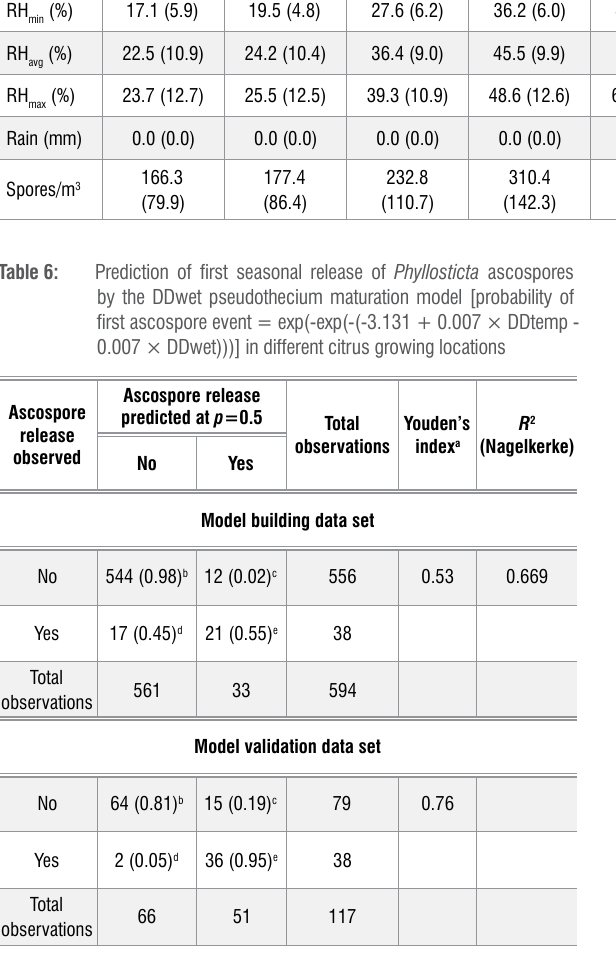
When compared with the temperature and temperature/moisture pseudothecium maturation models, described by Fourie et al. 25 ,